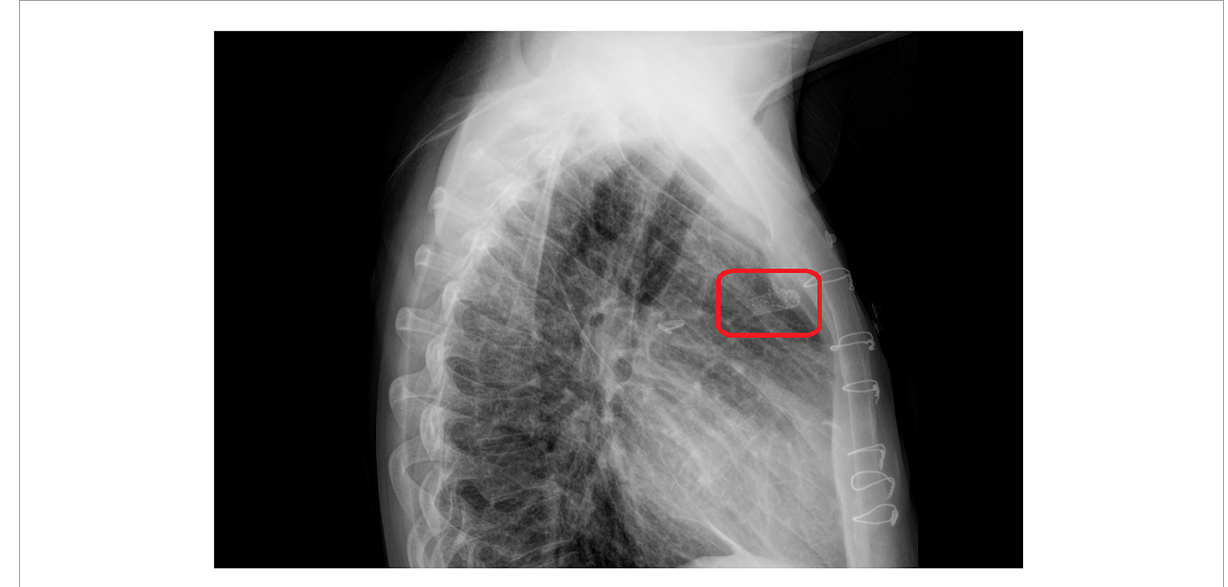
FIGURE5 The chest X-ray on the 1 day after stent implantation. The red rectangle showed stent in the central shunt that places in a proper location without mispositioning.